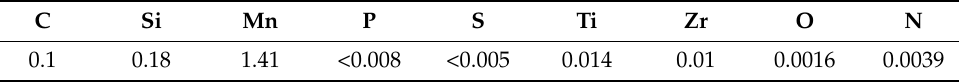
Table 1. Chemical composition of the experimental steel (mass%).